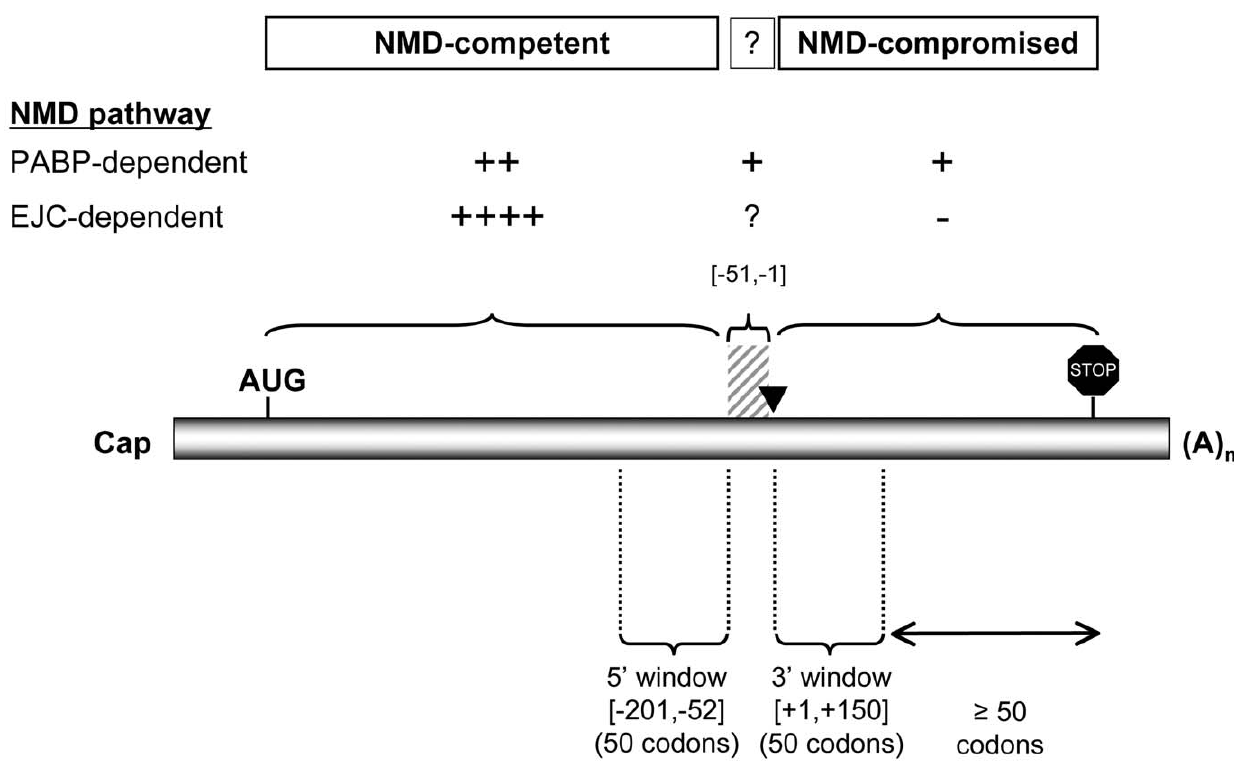
Figure 3. Intragenic depletion of fragile codons commences beyond the boundary of EJC–dependent NMD activity. Normalized fragile codon usage (NFCU) in ‘‘NMD-competent’’ and ‘‘NMD-compromised’’ regions of multi-exon genes. The schematic depicts a generic mammalian mature mRNA. The arrowhead shows the position of the last exon-exon junction. The relative efficiency of each mammalian NMD pathway predicted in three distinct regions is shown using ‘ + ’ symbols. Predicted inactivity of NMD is shown using a ‘-’ symbol. EJC-dependent NMD is expected to be active . 50–55 nts 5 9 of the last exon-exon junction and inactive 3 9 of the last exon-exon junction. Its activity is uncertain in the intervening 50–55 nts region (hatched shading). PABP-dependent NMD is expected to increase in efficiency with distance from the poly-A tail. Note that the efficiency of PABP-dependent NMD is predicted to be much lower than that of EJC-dependent NMD. NFCU was determined in two windows of 50 codons positioned on either side of the last exon-exon junction. The example shows the last intron in ‘‘phase 0’’ (i.e. the intron is positioned between codons) and the depicted nucleotide coordinates for each window are specific to this case.